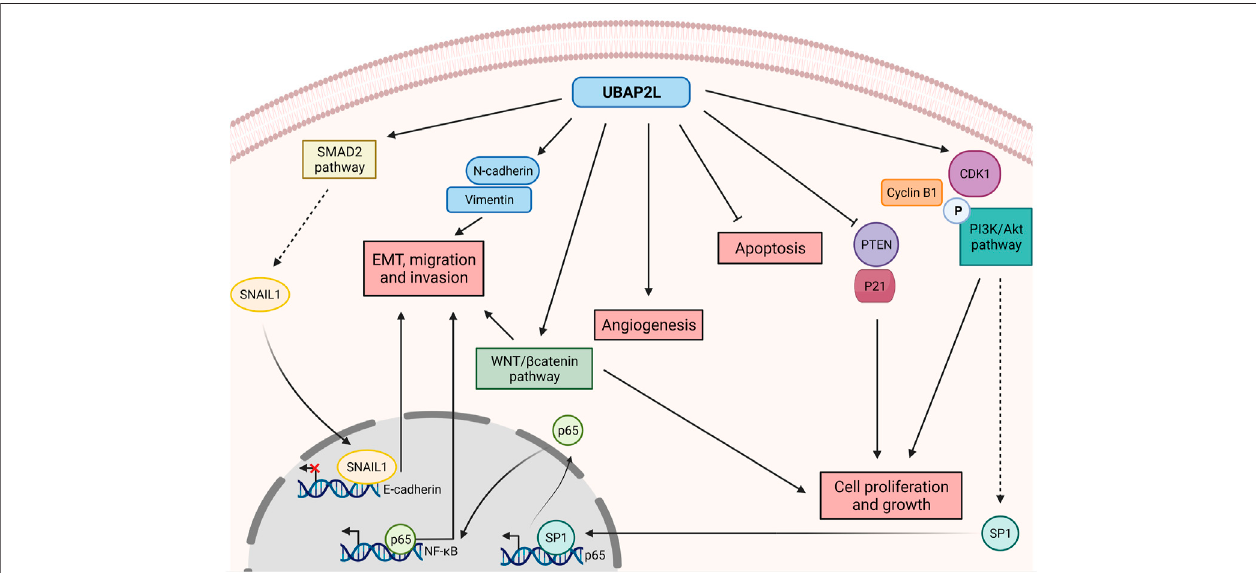
FIGURE 2 | Versatile roles of UBAP2L in promoting cancer disease. UBAP2L upregulates key cell cycle regulators such as CyclinB1, CDK1 and the PI3K/Akt pathway, while it inhibits the expression of tumor suppressors such as PTEN and P21, thereby promoting cell proliferation and growth. PI3K/Akt activation enhances SP1 levels which in turn activates P65 expression, thereby activating NF- κ B pathway and favoring epithelial-mesenchymal transition (EMT), migration and invasion. The metastatic potential of UBAP2L-overexpressing cells is also sustained by the activation of the SMAD2 pathway, triggering the transcriptional repressor SNAIL1 to theE-cadherinpromoter,shuttingdownitsexpression.CancercellsoverexpressingUBAP2LarecharacterizedbyhyperactivationoftheWNT/ β cateninpathwayandby upregulation of mesenchymal factors such as N-cadherin and Vimentin, resulting in increased invasion and proliferation. Finally, UBAP2L favors tumor vascularization while inhibiting cancer cells apoptosis. Overall, UBAP2L promotes cancer progression by regulating various axes of tumorigenesis known as the hallmarks of cancer.